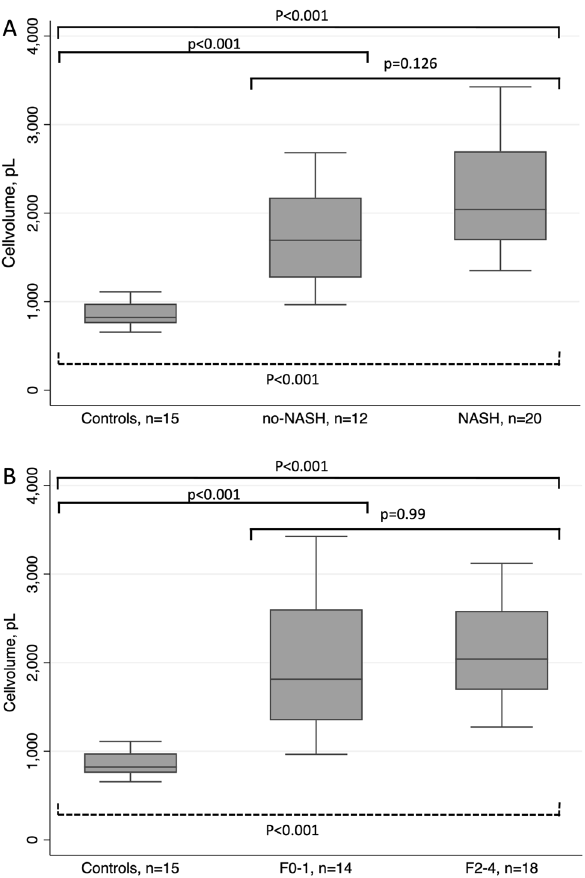
Figure 1. Boxplot showing comparison of adipocyte volume between healthy controls matched for BMI and ( A ) NASH and non-NASH and ( B ) no- or mild fibrosis (F0-1) versus significant or advanced fibrosis (F2-4). P at solid brackets denotes significance for multiple regression analysis adjusted for T2D, sex and BMI. P at dashed bracket denotes significance for Kruskal–Wallis test